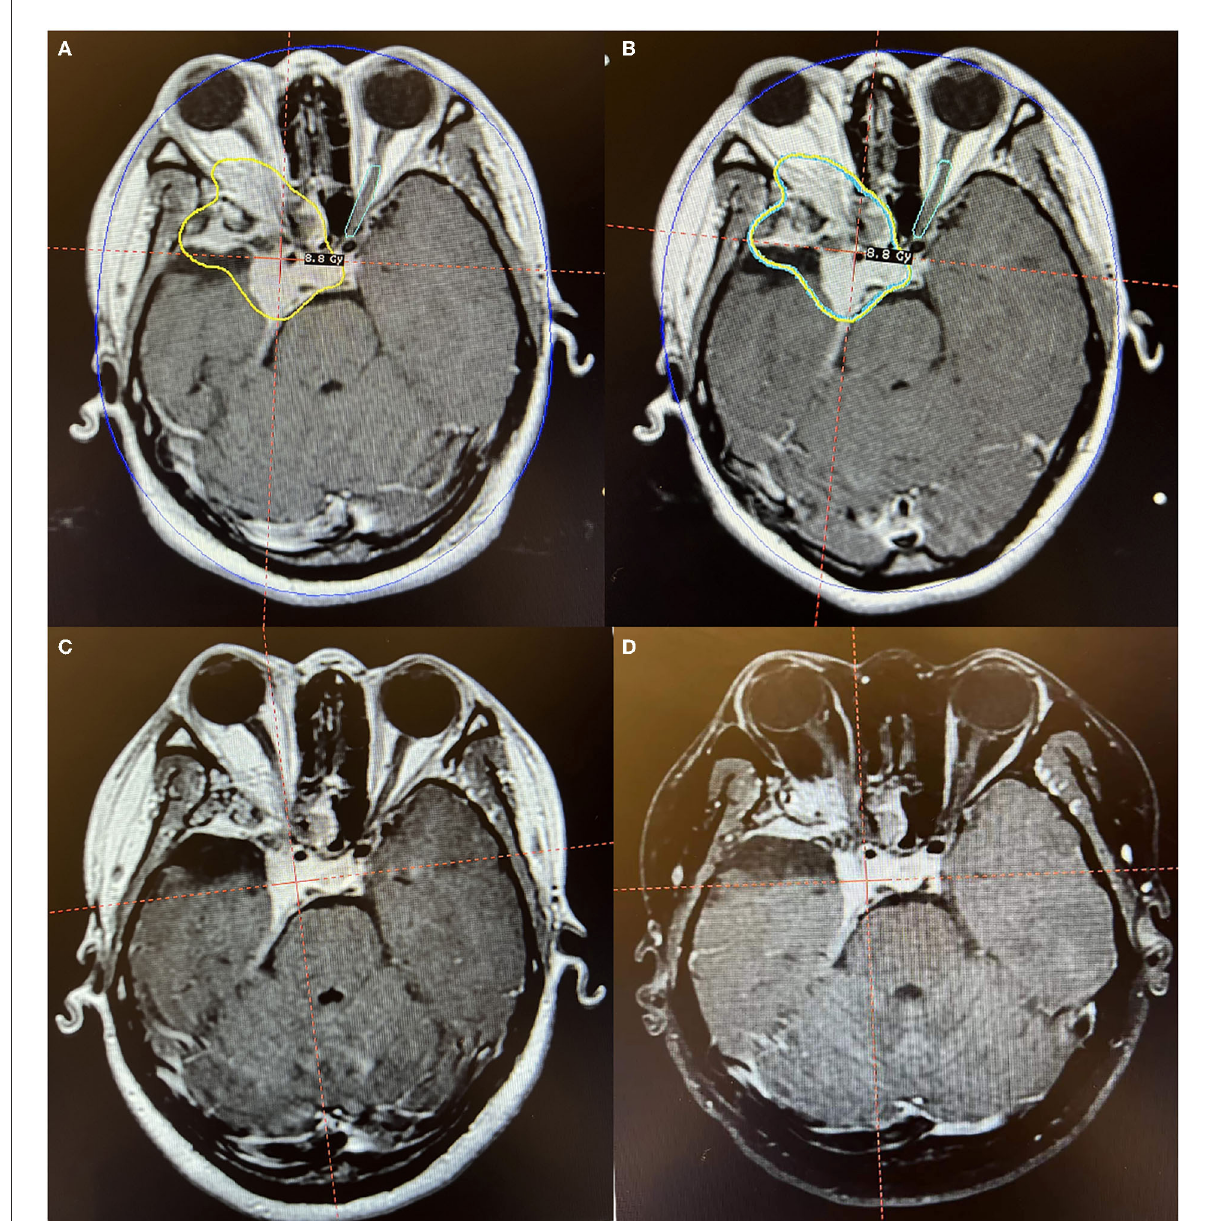
FIGURE3 Axial MR imaging illustrating a huge postoperative residual orbitocranial meningioma post-operation treated with Gamma Knife radiosurgery. (A) The prescription dose planning MRI for the first stage of Gamma Knife radiosurgery showing that the tumor margin was covered by 8.8Gy (45% isodose surface). (B) The prescription dose planning MRI for the second stage of Gamma Knife radiosurgery demonstrated that the tumor decreased by 9.8% and was treated with the same dose as the first stage. (C) MRI obtained 12 months after radiosurgery presented a decrease of 27.3% in tumor size. (D) MRI obtained 36 months after radiosurgery manifested that the tumor is under stable control. The patient’s right eye was blind before radiosurgery. After Gamma Knife treatment, there were no obvious adverse reactions, and the vision of the left eye was